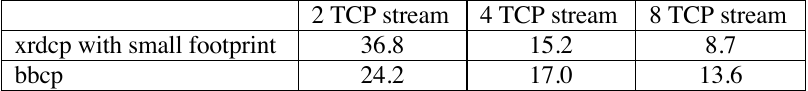
Table 2 . xrdcp and bbcp performance are